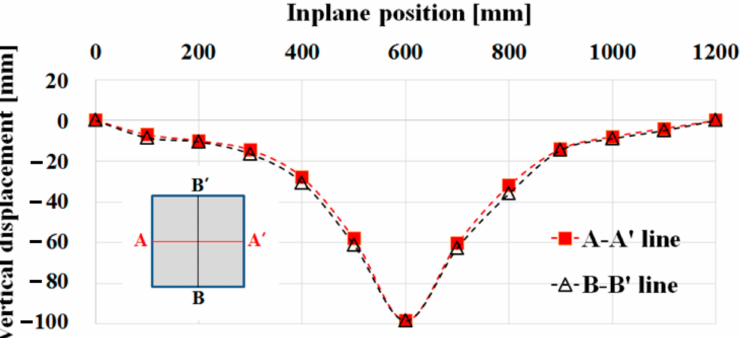
Figure 15. Vertical displacement of the drop impact experiment (drop height of 5